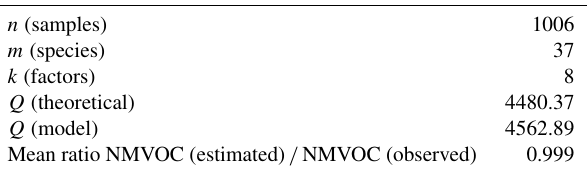
Table 1. Diagnostic for the results of the positive matrix factoriza- tion (PMF) model run.